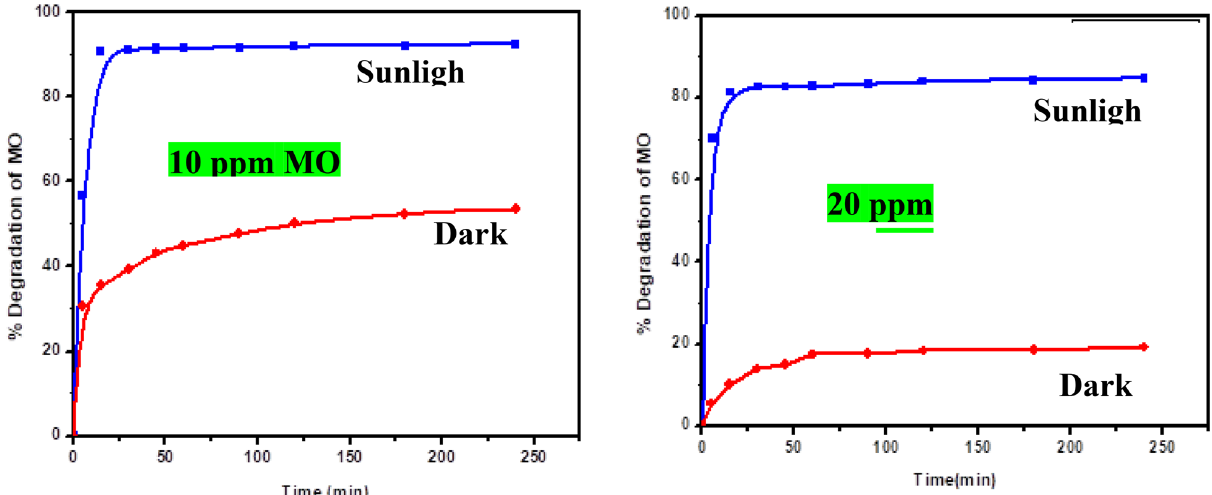
Figure 15. influence of the sunlight irradiations on the degradation efficiency for MO [10 and 20 ppm, respectively] over Zn–Fe LDH at different irradiation